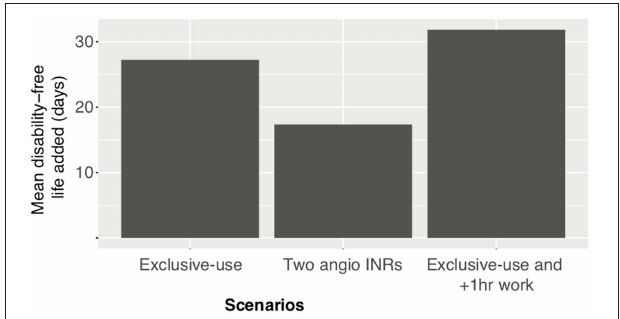
FIGURE 4 | Disability-free life gained under various scenarios.